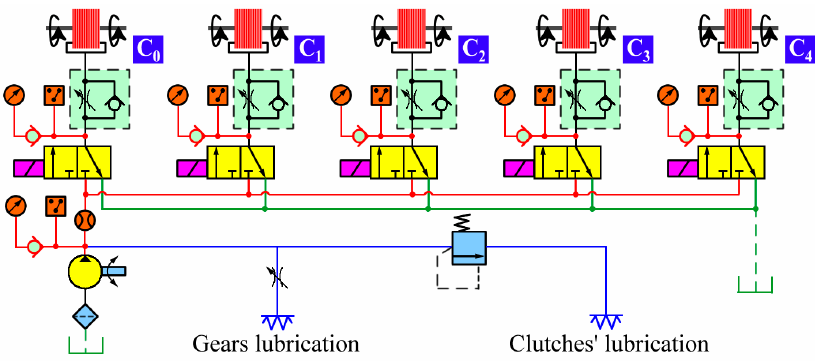
Figure 2. Schematic diagram of clutch hydraulic control system.